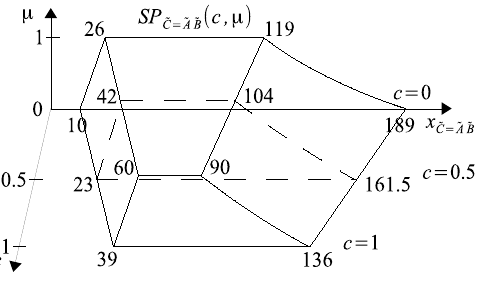
( c , µ ) of the multiplication result ˜ C = ˜ A ˜ B according to Formula (48). Figure 26. Span function SP ˜ C = ˜ A ˜ B